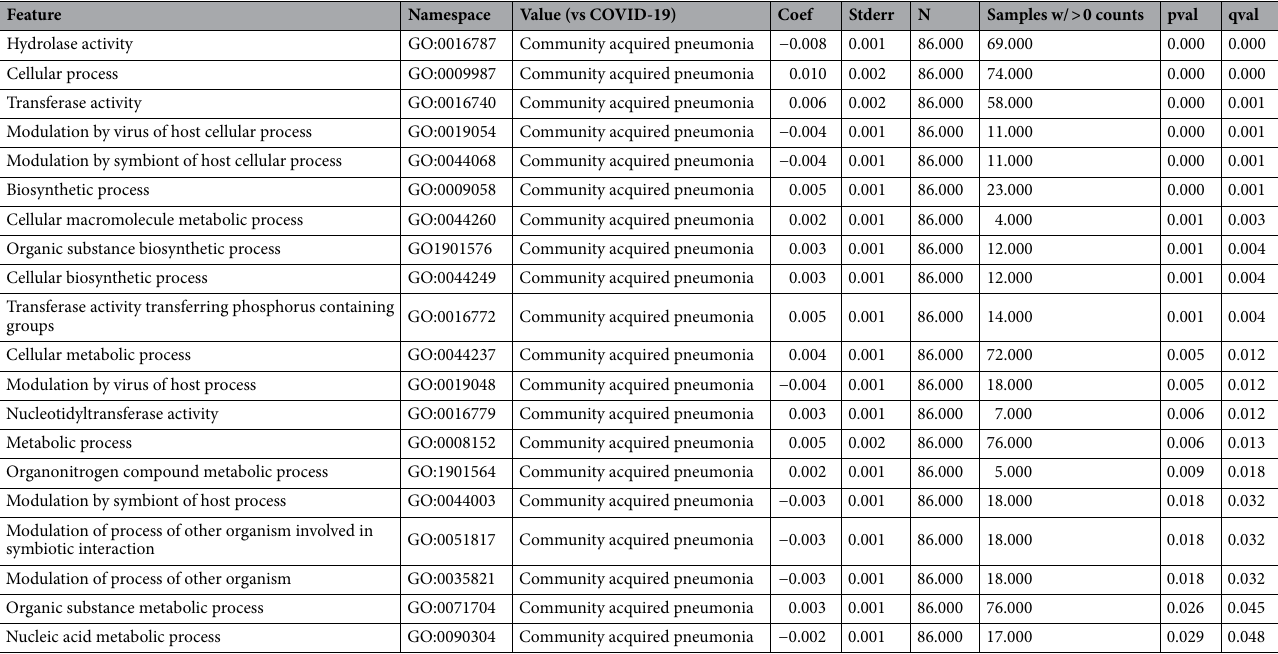
Table 2. MaAsLin2-derived significant gene ontologies associated with COVID-19 (n = 32) when compared to the community acquired pneumonia (n = 25) cohort. Comparisons were conducted using compositional transformed and CLR normalized count matrices, controlled for the random effects of publication and patient, and adjusted for multiple test comparisons using the Benajmini Hochberg correction method. A full list of statistically significant GO terms in COVID-19 vs. CAP can be found in Suppl. Table